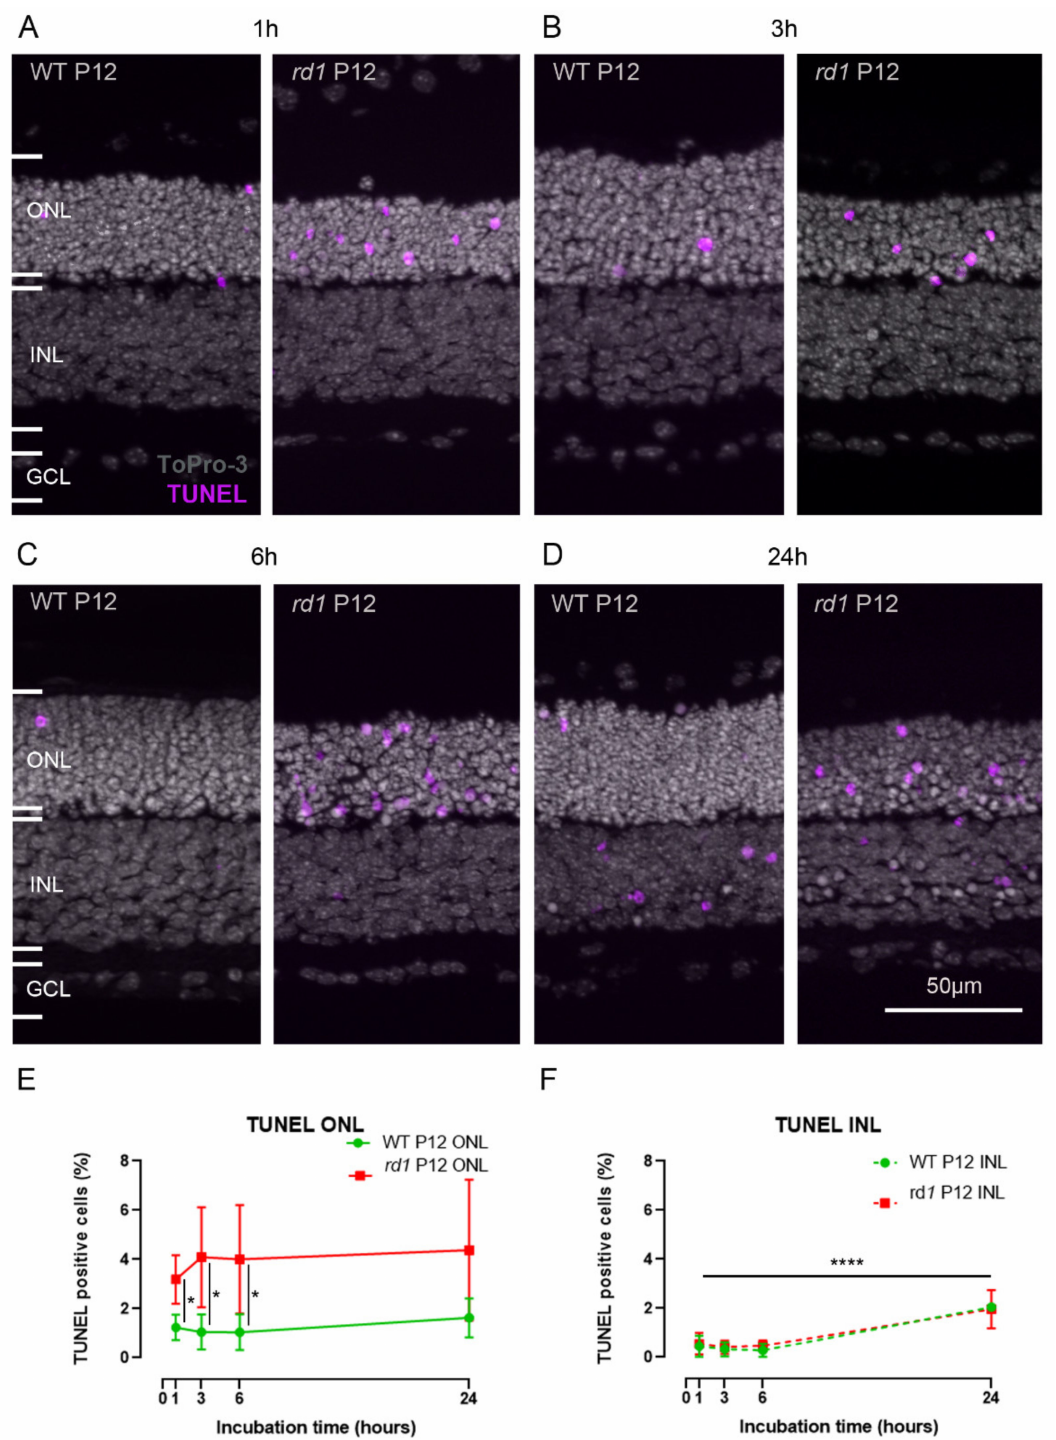
Figure 3. Cell death in live tissue treated with the CMAC substrate. Organotypic retinal explant cultures derived from the rd1 mouse model were incubated with 50 µ M CMAC for 1 h ( A ), 3 h ( B ), 6 h ( C ), or 24 h ( D ). A TUNEL assay for cell death detection was carried out on fixed tissue sections. Percentage of TUNEL-positive cells in the outer nuclear layer (ONL) ( E ) and the inner nuclear layer (INL) ( F ). To-Pro-3 was used as nuclear counterstaining. Images are representative of results obtained from four to nine independent retinal explant cultures; error bars indicate STD; statistical analysis: two-way ANOVA with Holm–Sidak’s multiple comparisons test; * = p < 0.05; **** = p < 0.0001; GCL = ganglion cell